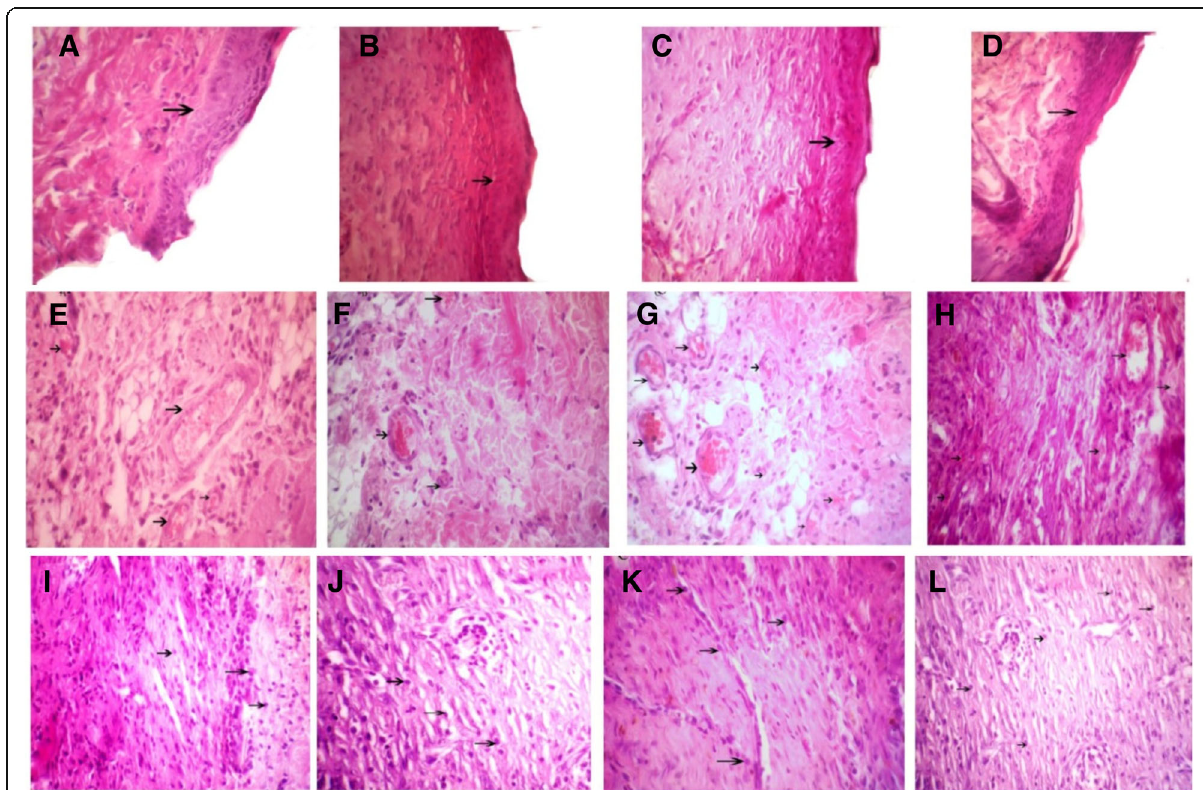
Fig. 6 Arrows show the wound epidermis regeneration ( a – d ), vascular formation ( e – h ), and granulation ( i – l ) on the seventh day. a , e , i Satureja khuzistanica -treated group. b , f , j Hydrogel alginate-treated group. c , g , k Satureja khuzistanica encapsulated in hydrogel alginate-treated group. d , h , l Control group. Arrows show the re-epithelialization with mild hyperplasia of the epidermis and moderate hyperkeratosis ( a – d ) and immature granulation tissue ( i – l ) with emerging blood vessels (angiogenesis) shown in black arrows and fibroblasts and numerous macrophages. Hematoxylin and eosin stain (×